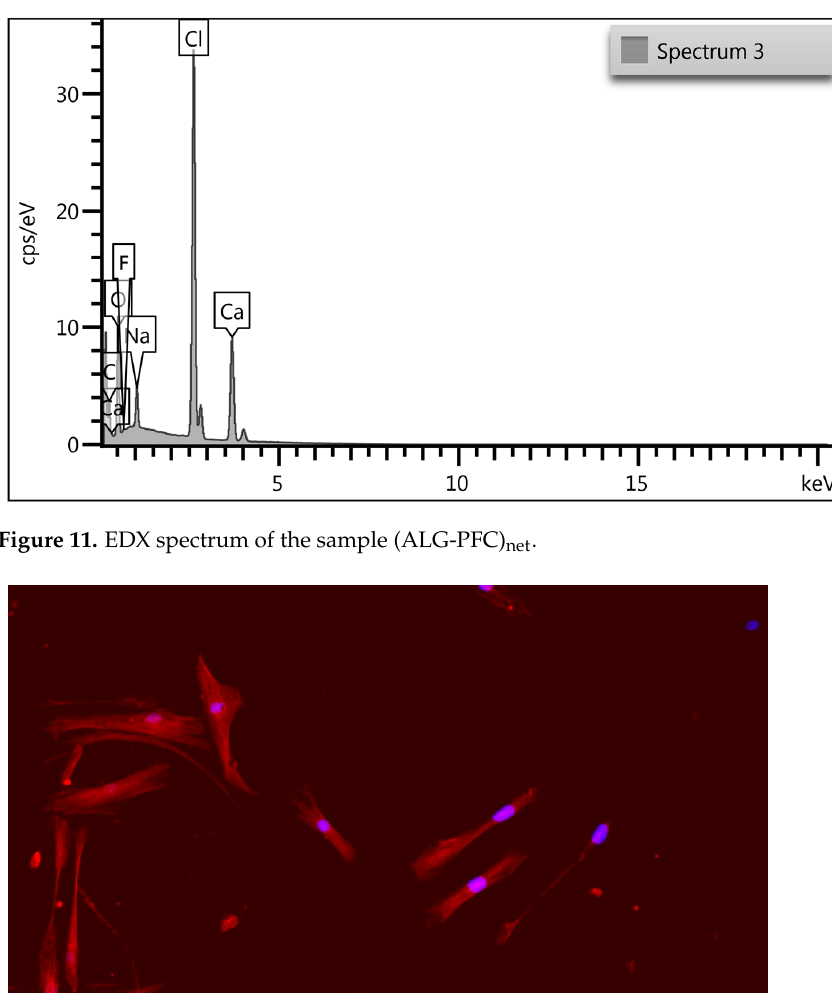
Figure 12. Fluorescence microscopy image of human fibroblast cells cultured in the presence of the alginate–perfluorooctyl (ALG-PFC) coating after a 6-day culture.